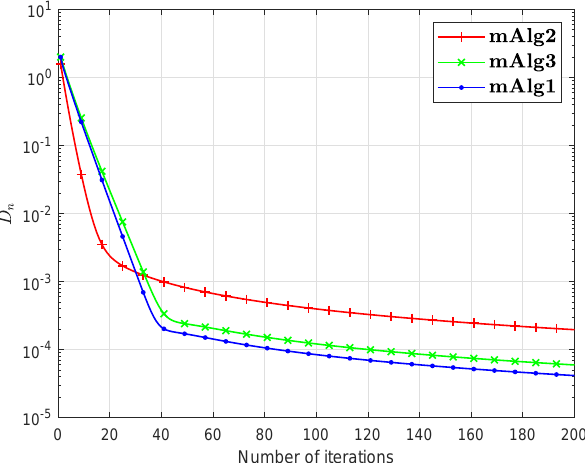
Figure 2. Algorithm 1 compared to Algorithm (60) and Algorithm 3.2 in [34] for R 10 .